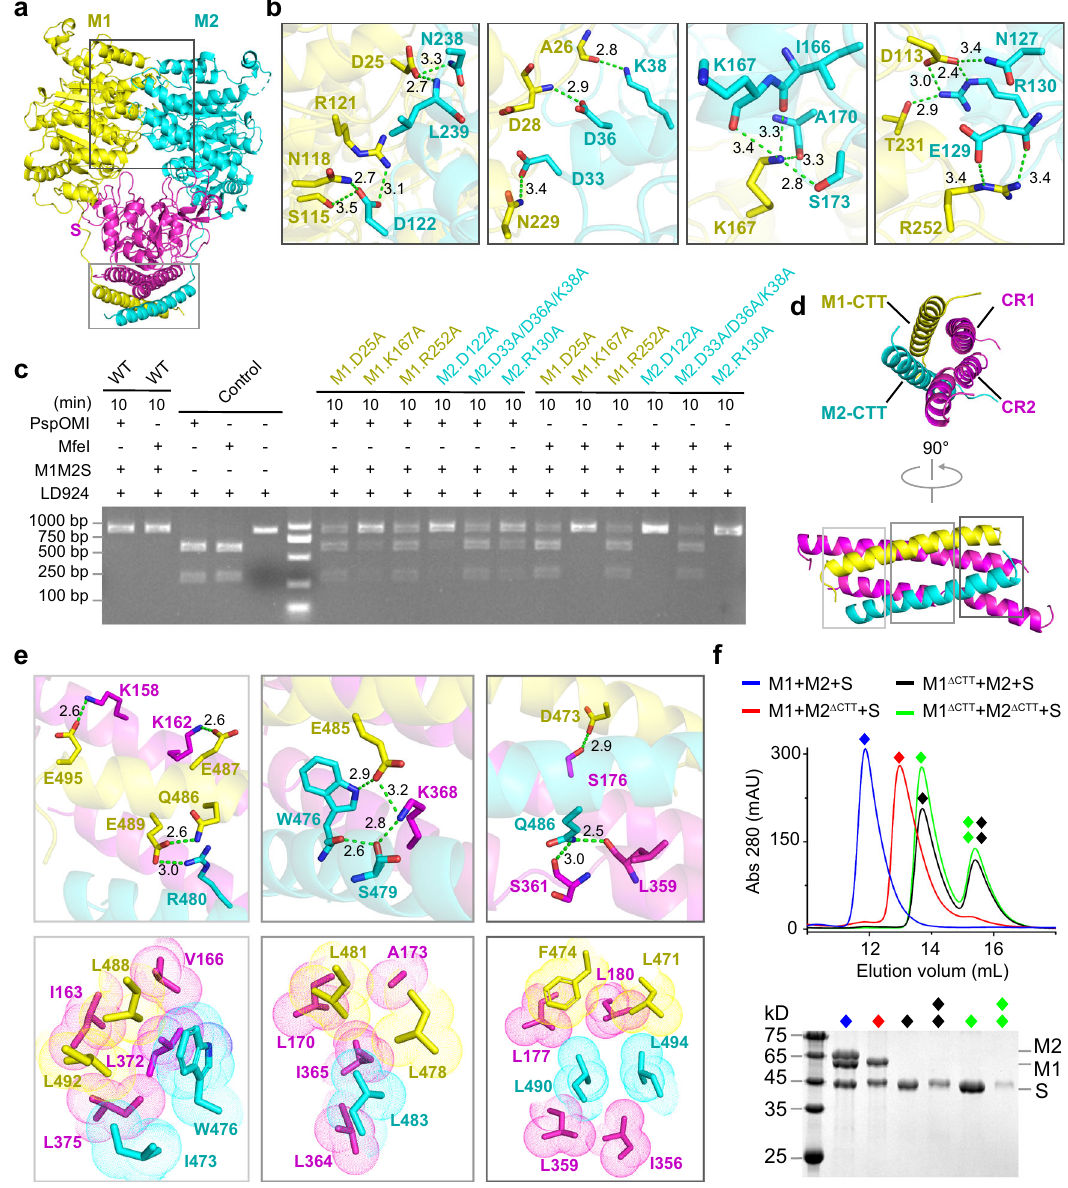
Fig. 2 | Intermolecular interactions of PacII_M1M2S heterotrimer complex. a Overall view of M1-M2 interface and four-helix bundle interface. b Detailed interactions of M1-M2 interface. Green dashed lines indicate hydrogen bonds. c PspOMI/MfeI-digestionanalysisofmutationswithinM1-M2interface. d TheFour- helix bundle interface formed by CR1 and CR2 of S subunit, and CTTs of both M subunits as show in ( a ). e Hydrogen bonding (up) and hydrophobic (down) inter- actions within the four-helix bundle as show in ( d ). Green dashed lines indicate